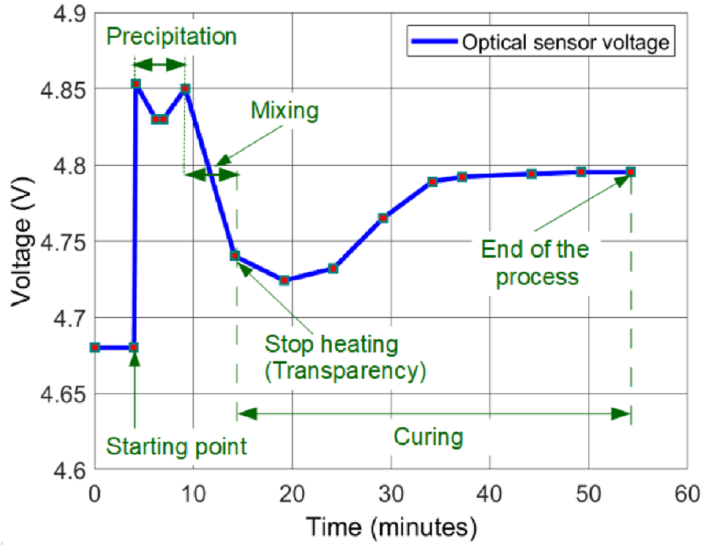
Figure 7. Different values of the optical sensor voltage as a function of the